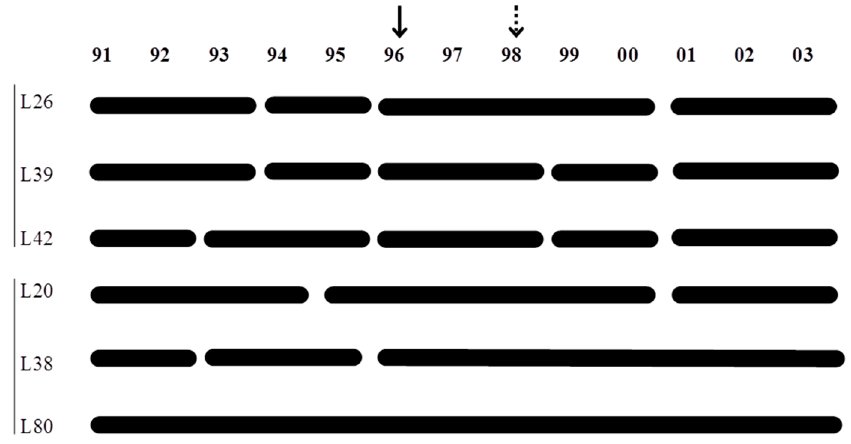
Figure 5. Time clusters on the variation in zooplankton abundance in each monitored lake based on multiple regression tree analysis. Full arrow shows the first year of clearcut logging in 1996 and the dotted arrow represents the second partial logging in 1998 for L39 and L42.